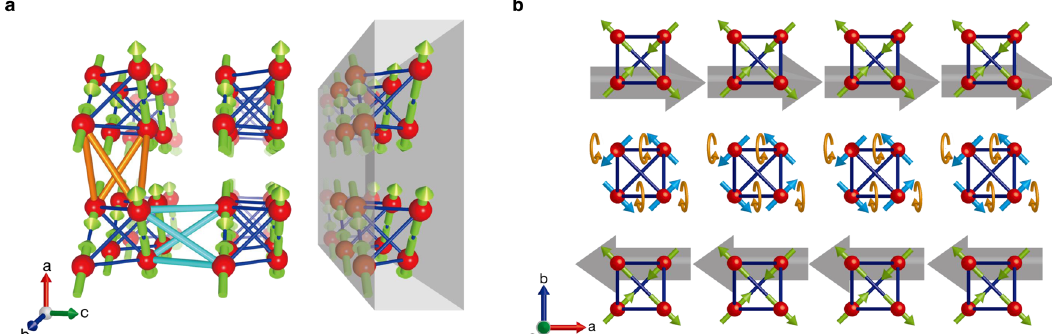
Fig. 5 Two- and one-dimensionalisation by geometrical frustration in pharmacosiderite. a Schematic representation of the q = 0, Γ 5 magnetic structure with all the spins perpendicular to the horizontal c axis. The red, blue, and green arrows indicate the crystallographic a , b , and c axes, respectively. Among the six intercluster J ′ paths from a focused spin in a tetrahedron, the two paths to the pair of antiparallel spins along the c axis (sky-blue bonds) geometrically cancel each other because the total S equals 0 for the pair. In contrast, the paths to either pair of spins along the a or b axis (orange bonds) do not; spins in either pair are not antiparallel to each other. This results in a slab perpendicular to the c axis, in which SWs are effectively con fi ned. b 1D defect along the a axis, which is made of Γ 4 tetrahedra with blue spins and is generated without energy loss in the slab shown in a of the q = 0 magnetic structure made of Γ 5 tetrahedra with green spins. The red, blue, and green arrows indicate the crystallographic a , b and c axes, respectively. The large grey arrow represents the sum of a pair of spins at an edge of the tetrahedron next to the 1D defect, which is parallel to the a axis and exerts an effective axial magnetic fi eld to the spins of the 1D defect. Under the axial effective fi elds, all the blue Γ 4 spins in the 1D defect can rotate collectively along the a axis while keeping the total spin zero and are continuously transformed into the Γ 5 arrangement without losing energy in the intercluster couplings to the surrounding. This means that such a 1D defect can be generated and annihilated without energy loss in the 2D slab of the q = 0, Γ 5 magnetic structure in the classical spin